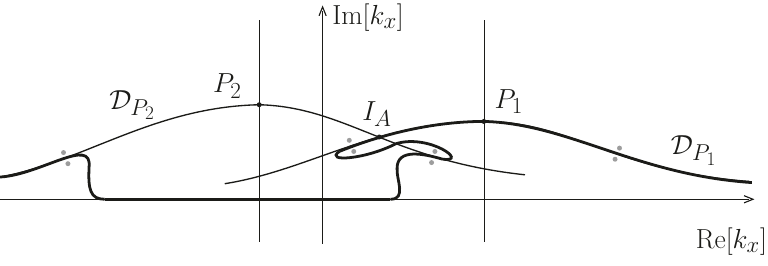
Figure 13 . Domain deformation in the presence of multiple thresholds with di(cid:11)erent external momenta p and q . The grey dots are the points k (cid:6)